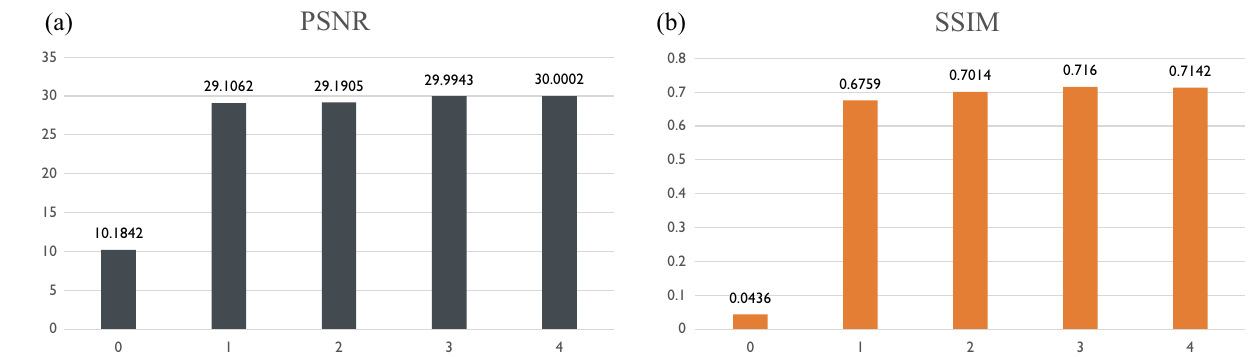
Figure 6. Quantitative evaluation indices for the discrepancy between true and estimated high-resolution CT images. ( a ) PSNR and ( b ) SSIM are shown as functions of the number of iterations. images included many sharp structures not seen in the true high-resolution image. The quantitative evaluation indices also demonstrated the superiority of the dictionary obtained from rock CT images, which had a greater PSNR (30.12) than the dictionary obtained from standard images (27.32) as well as SSIM. These results suggest that the basis images extracted by sparse super-resolution include the essential characteristics of the rock textures.